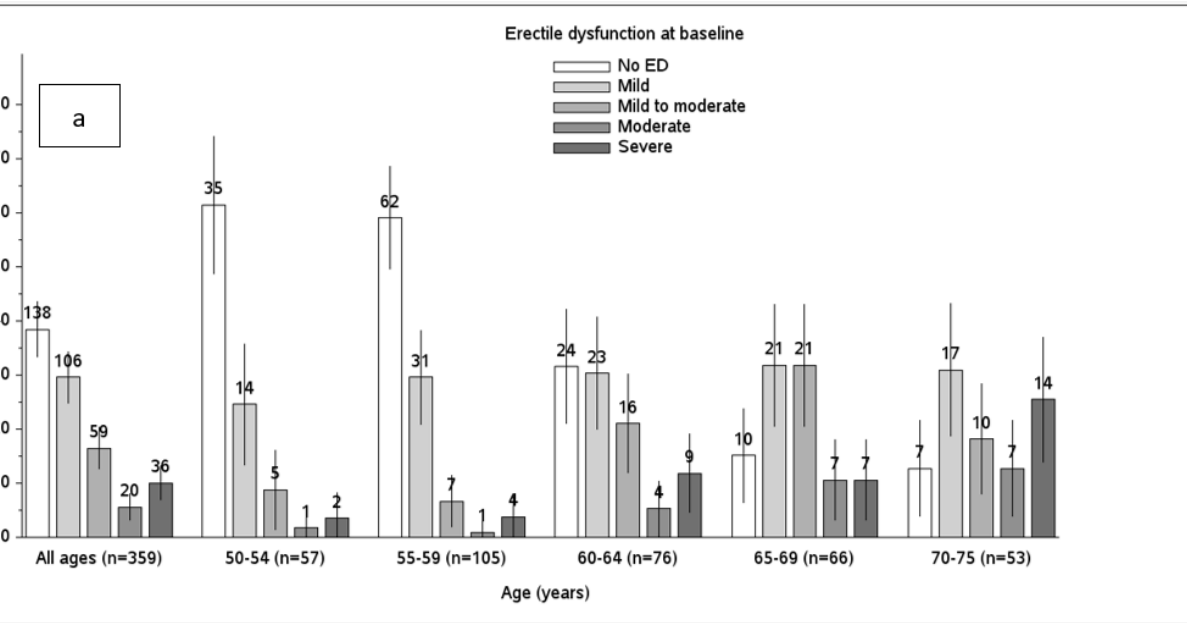
Figure 2. The proportion of men who reported a normal erection ability, or mild, mild to moderate, moderate, or severe ED at the baseline ( a ) and at the twelve-year follow-up ( b ). The figures shown above the bars illustrate the number of men, and the vertical lines show the 95% confidence intervals for the prevalence of ED. The crude prevalence of ED was 61.6% at the baseline and 78.9% at the twelve-year follow-up. The prevalence of ED increased with age. Out of the youngest age group (aged between 50 and 54 years), a total of 38.6% had ED, while all of the men who were older